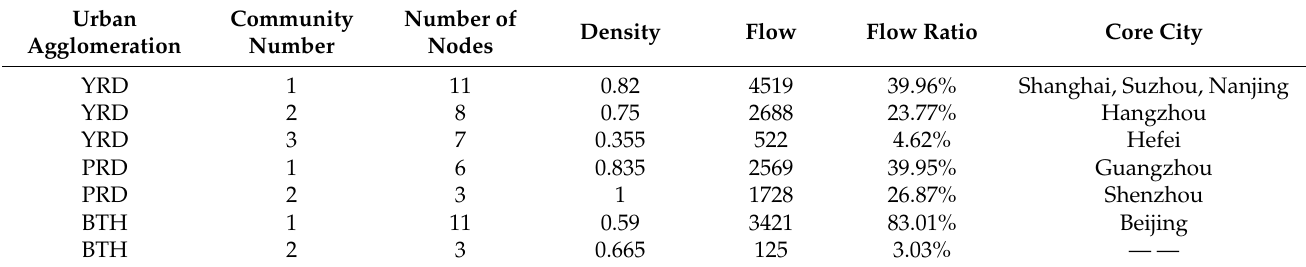
Table 4. Community statistics of three major urban